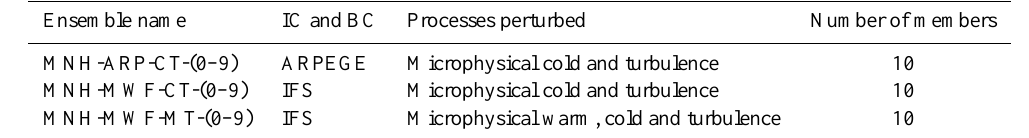
Table 2. Characteristics and labelling of Meso-NH ensembles performed for the case of 4 November 2011. The ensemble MNH-MWF-MT was not used to perform hydrological experiments. Differences between this and the MNH-MWF-CT ensemble were used to underline the influence of the microphysical processes.